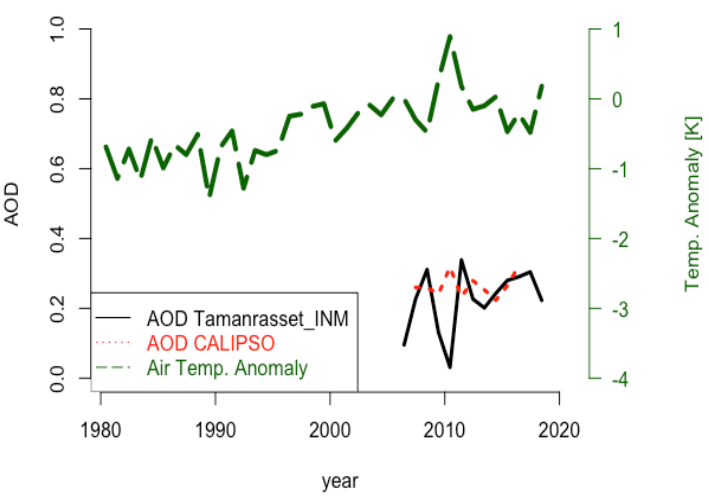
Figure 3. Time-series of aerosol optical depth (AOD) measured by AERONET permanent observing sites (Po Valley: Modena, 44.63°N, 10.94°E, Elevation 56 m; Ispra, 45.80°N, 8.63°E, Elevation 235 m; Benelux: Lille, 50.61°N, 3.14°E, Elevation: 60 m; Brussels, 50.78°N, 4.35°E, Elevation: 120 m; Cabauw, 51.97°N, 4.93°E, Elevation − 1 m; Sahara: Tamanrasset INM, 22.79°N, 5.53°E, Elevation 1377 m) and from space by CALIPSO, together with the temperature anomalies computed over the 10-year period covered by satellite measurements (2007–2016). The upper panel represents the Po Valley, the middle panel represents the Benelux, and the lower panel represents the